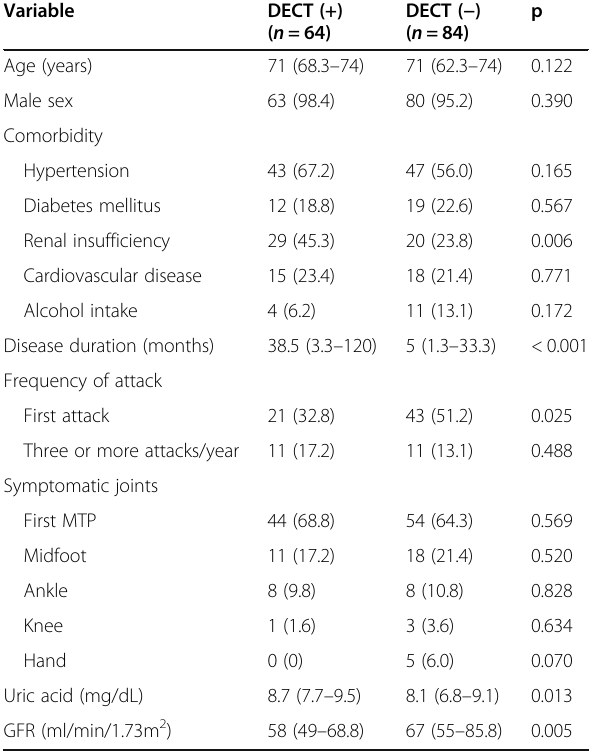
Table 1 Baseline characteristics of the patients with clinical